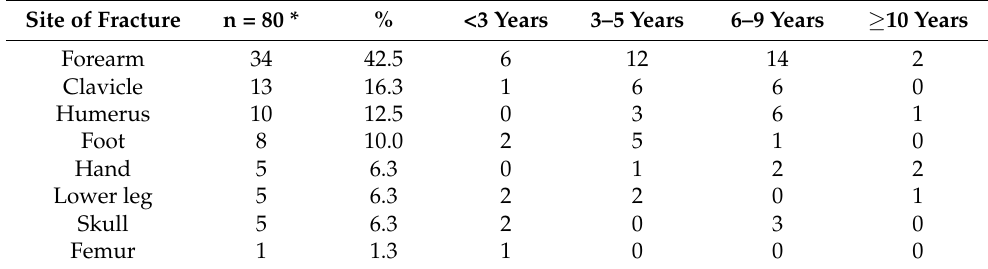
Table 2. Type and rate of BBR fractures (one child sustained a combined fracture of the humerus and forearm).